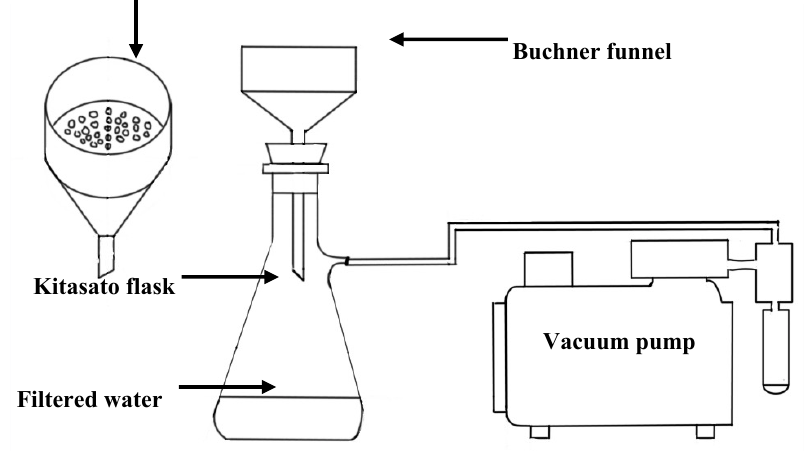
Figure 8. Apparatus used to evaluate water filtration performance of CNF/PCL membrane.